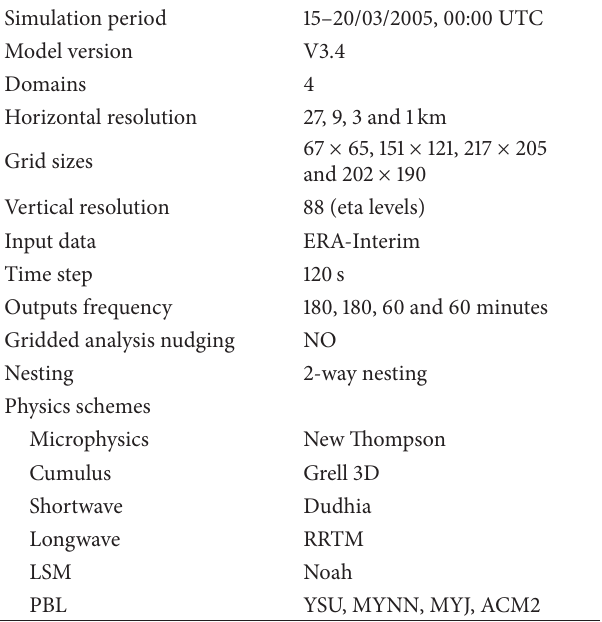
Table 4: A synopsis of the WRF model configuration used by EDF R&D for the stable period: 16 – 18 March